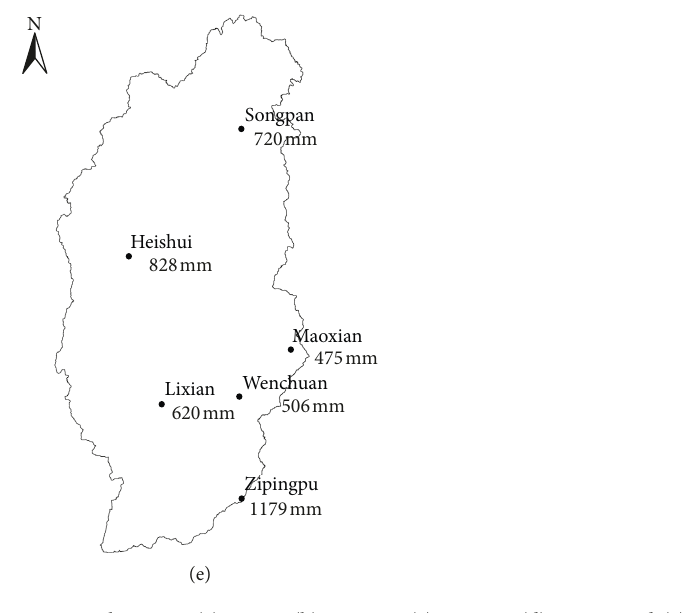
Figure 2: Spatial distributions of precipitation in the UMR (a) spring (b) summer (c) autumn (d) winter and (e) annual.